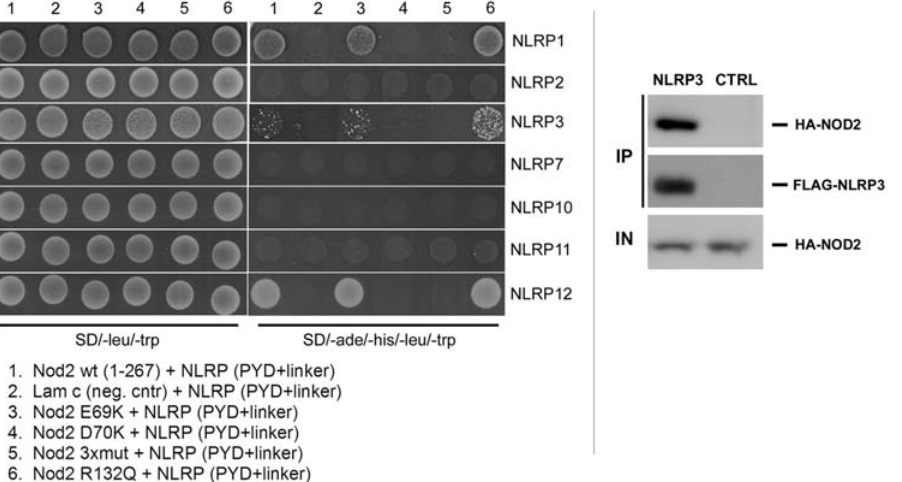
Figure 5. NOD2 directly interacts with NLRP1, NLRP3, and NLRP12. Left panel , Yeast two-hybrid analysis of NOD2 CARDs (residues 1–267) showed interaction with NLRP1,-3 and -12, but not with other NLRP proteins (NLRP2, -7, -10, or -11; column 1). Lam c was used as a negative control (column 2). Interestingly, NOD2 mutant E69K maintained the binding to NLRP1, -3, and -12 (column 3), whereas NOD2 D70K (column 4) as well as the NOD2 triple mutant (3xmut, column 5) did not. An unrelated mutation not located within the prospective interaction interface had no effect (column 6). Rightpanel , Physicalinteraction ofNOD2and NLRP3 in humancells.Westernanalysis oflysates (IN)and immunoprecipitated complexes (IP)fromHEK293T cells,transientlytransfectedwithexpression plasmidencoding humanHA-NOD2 andFLAG-NLRP3. NLRP3was immunoprecipitatedfrom celllysatesusing a FLAG-epitope specific antibody. Proteins were detected using anti-HA and anti-FLAG antibodies, respectively. As negative control, proteins were immunoprecipitated with FLAG-epitope specific antibody from lysates of HEK293T cells transiently transfected with HA-NOD2, but not